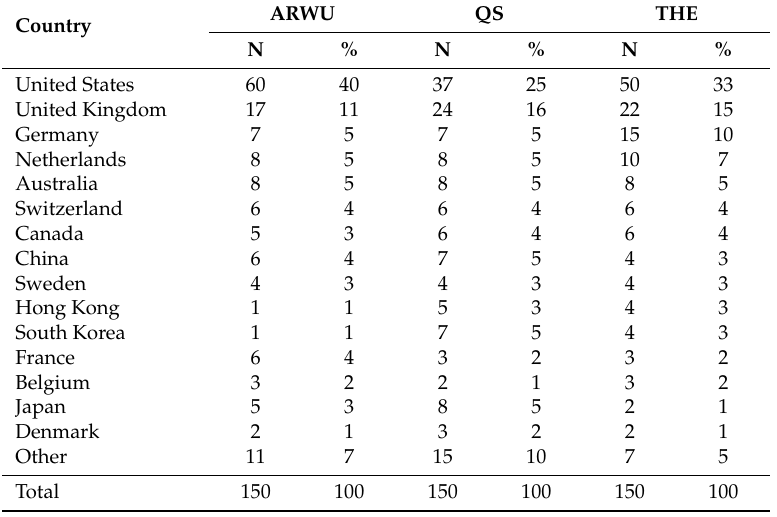
Table A2. Distribution of top-ranked universities by